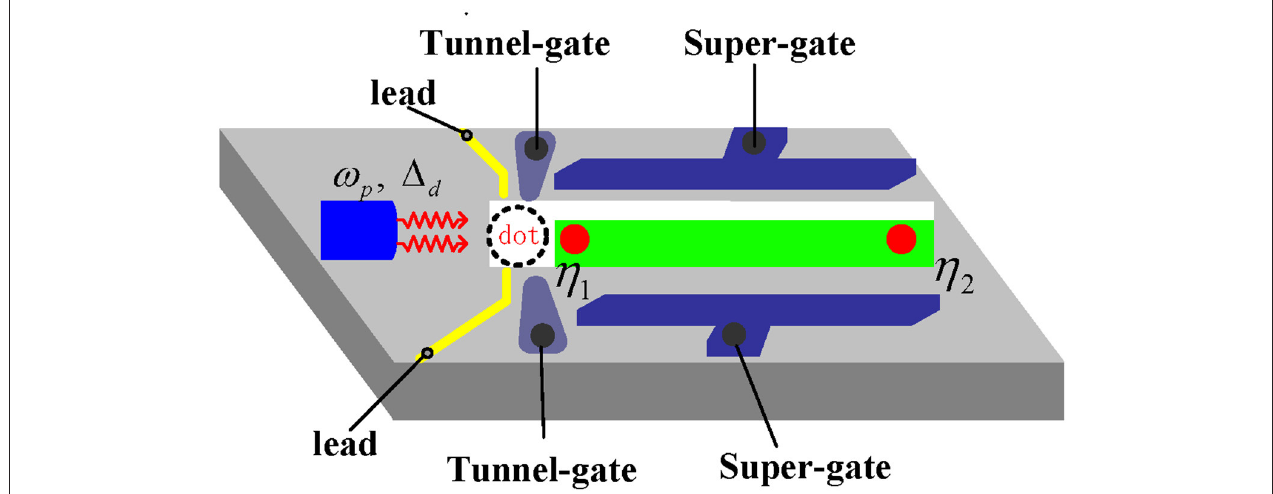
FIGURE 1 | Schematic plot of a QD (white circle) coupled to MBSs (red circles) formed at the two ends of a topological superconductor nanowire (green). The dot is connected to two normal metal leads (golden), and is shelled by a microwave field of strength 1 d and photon frequency ω p . The dot and the superconductor nanowire are individually defined by tunnel- and